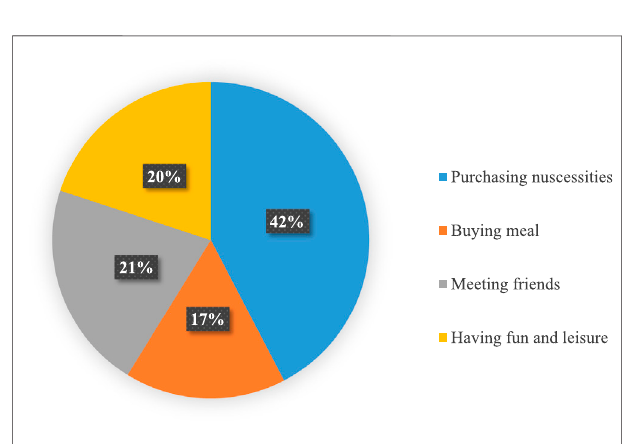
FIGURE 2 | Main reasons for went outside university campus among Debre Berhan University students, Northeast Ethiopia, 2021.